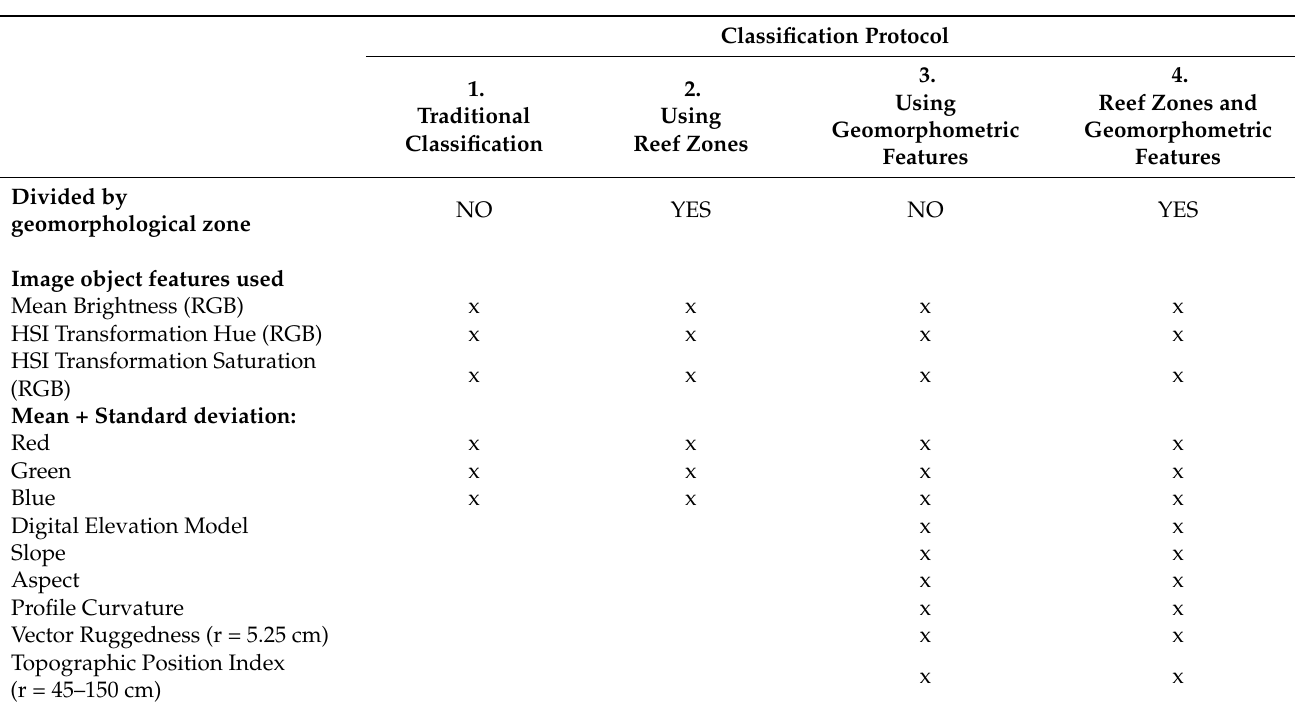
Table 2. Overview of the information used by the Random Forest classifier to perform habitat classification in the four different classification protocols conducted in this study. Classification